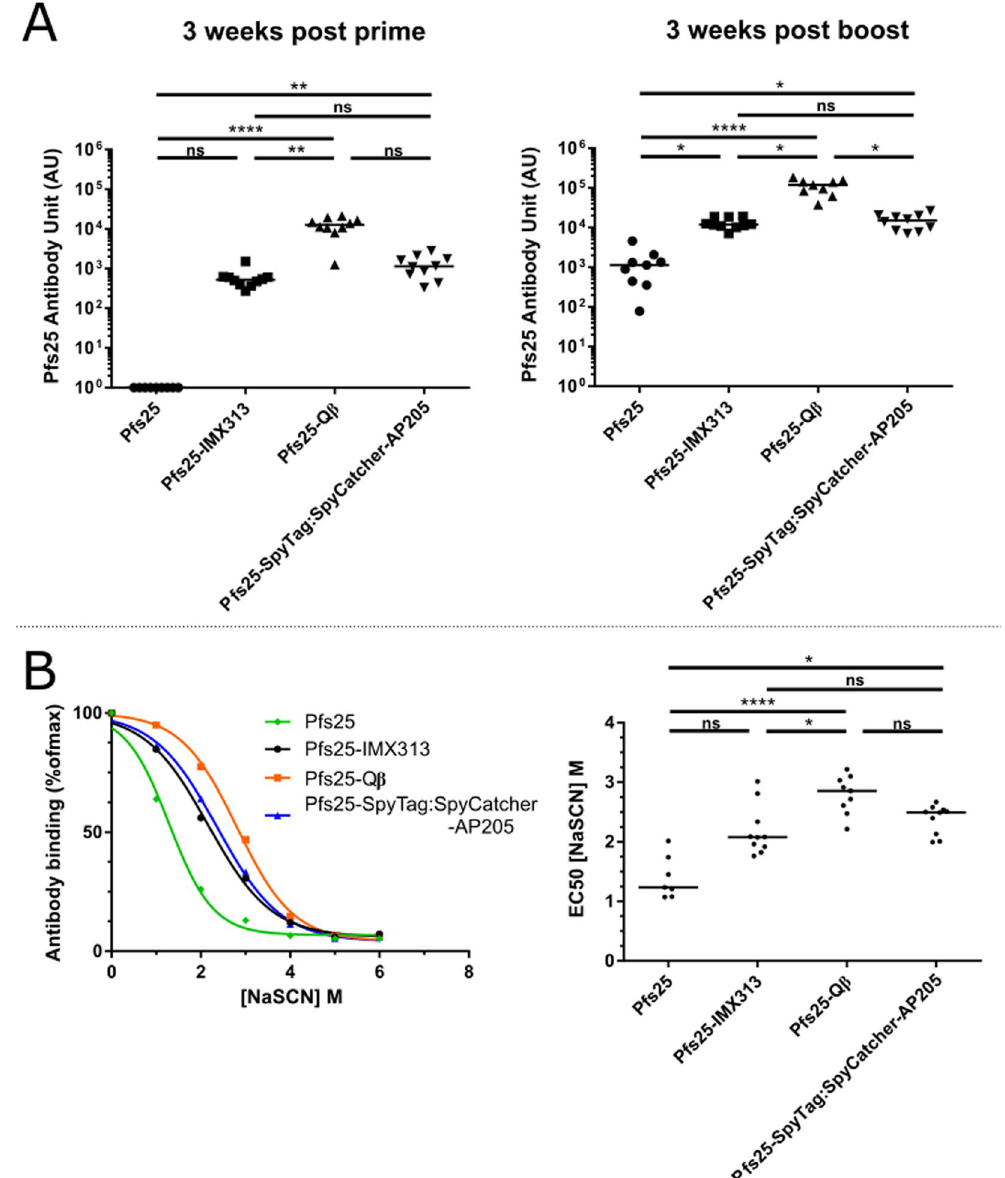
Figure 2. Immunogenicity of nanoparticle vaccines. ( A ) Anti-Pfs25 IgG titers measured by ELISA in mice (n = 10) vaccinated twice with doses corresponding to 1 μ g Pfs25 per immunisation in Alhydrogel ® at three weeks post prime (left panel) and three weeks post boost (right panel). ( B) Avidity of serum IgG responses was assessed by NaSCN-displacement ELISA and is reported as the reduction in OD by incubation with varying concentrations of NaSCN compared to incubation with PBS (left panel). Lines represent the arithmetic mean of the combined data from each mouse within the group. EC50 (concentration of NaSCN required to reduce the OD405 to 50% of that without NaSCN) was then determined using a sigmoidal dose response (variable slope) regression (right panel). ns p > 0.05, * p ≤ 0.05, ** p ≤ 0.01, *** p ≤ 0.001, **** p ≤